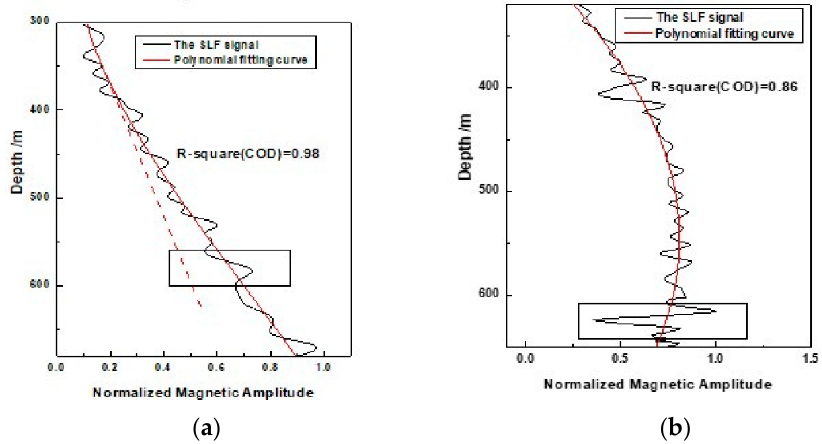
Figure 19. Extraction of EMR anomalies from measured magnetic amplitude curves. Note: the original data were collected from the vicinity of Well 1-8. The collection time is ( a ) 2011 and ( b ) 2012. Table 1. Statistical results of the reservoir depth interpretation accuracy of